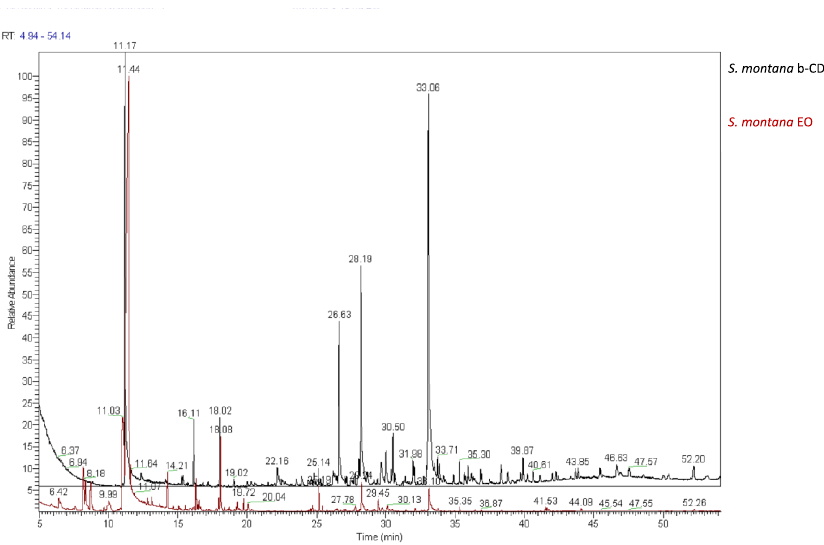
Figure 4. GC-MS chromatograms of S. montana EO (red line) and solid-state b-CD – EO-S (black line) samples.